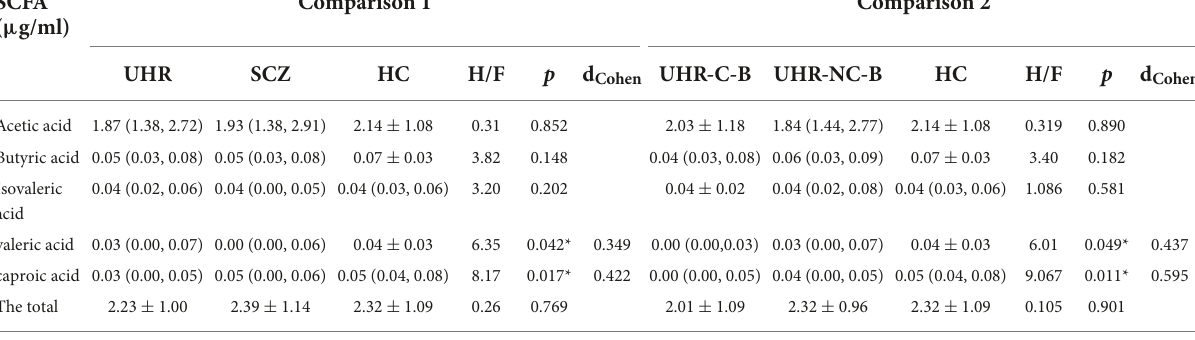
TABLE 4 Comparison of short-chain fatty acid (SCFA) level between different